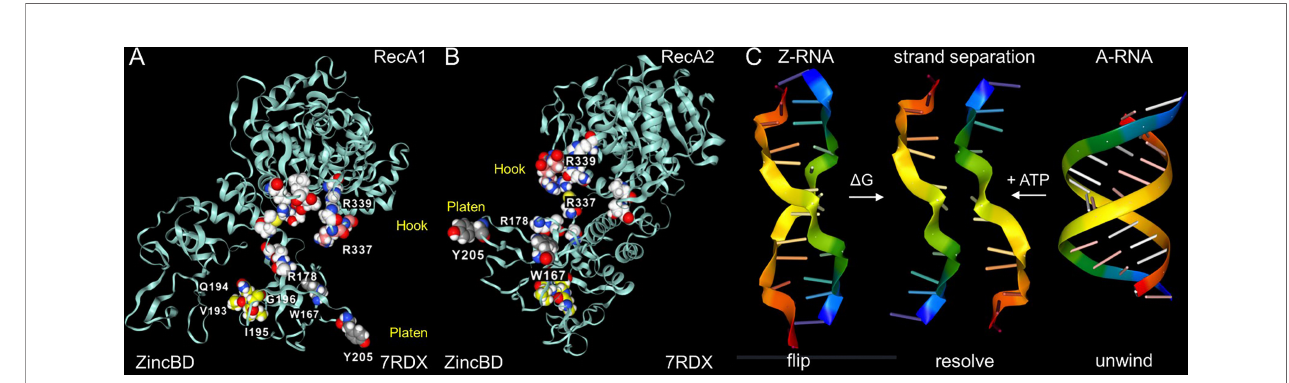
FIGURE 6 | Nsp13 opens to expose a hook and platen for binding dsRNA. (A) The arginine rich PARAR hook (crimson carbons) and the tyrosine (Y205, grey carbons) platen create a surface for docking dsRNA. Tryptophan (W168)(blue carbons) has the potential to orientate Y205 through and edge to face interaction and create a Z-RNA speci fi c recognition element like that present in the Z a domain that confers speci fi city for binding to the left-handed helix (48). In this open orientation, the RHIM (yellow carbons) is free to engage other RHIM proteins. The space fi ll with white carbons show the residues identi fi ed as making base-speci fi c contacts with single-stranded RNA (ssRNA) in the active conformation of Figure 5B (residues 178, 179, 230, 233 in domain 1B, residues 311, 335,361, 362:E,363, 390, 408, 410:E in RecA1). (B) The view of the Nsp13 molecule from the opposite side to that shown in the fi rst panel. (C) In addition to the ATP-dependent helicase activity, Nsp13 has the potential to capture ssRNA when Z-RNA fl ips to and from A-RNA. The higher energy Z-RNA powers the strand-separation, providing the DG needed to fuel the Z- fl ipon helicase activity we refer to as a Z- fl